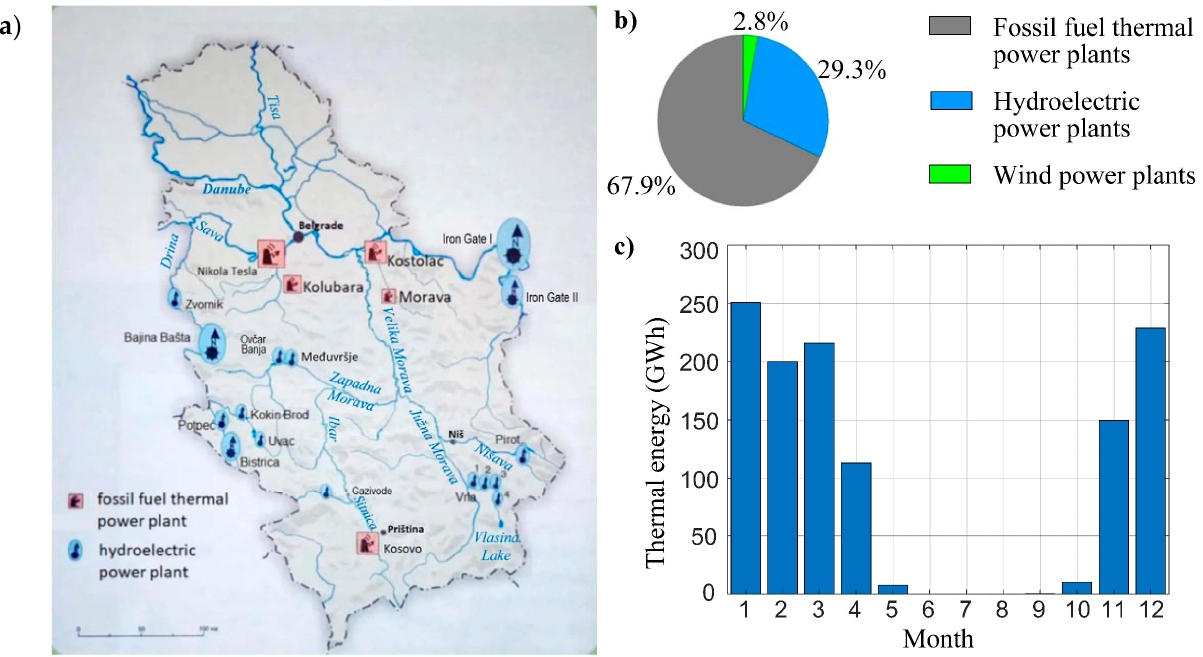
Figure 2. ( a ) Electric power plants in Serbia; ( b ) electrical energy generation structure in Serbia; ( c ) thermal energy produced in cogeneration power plants in Serbia.